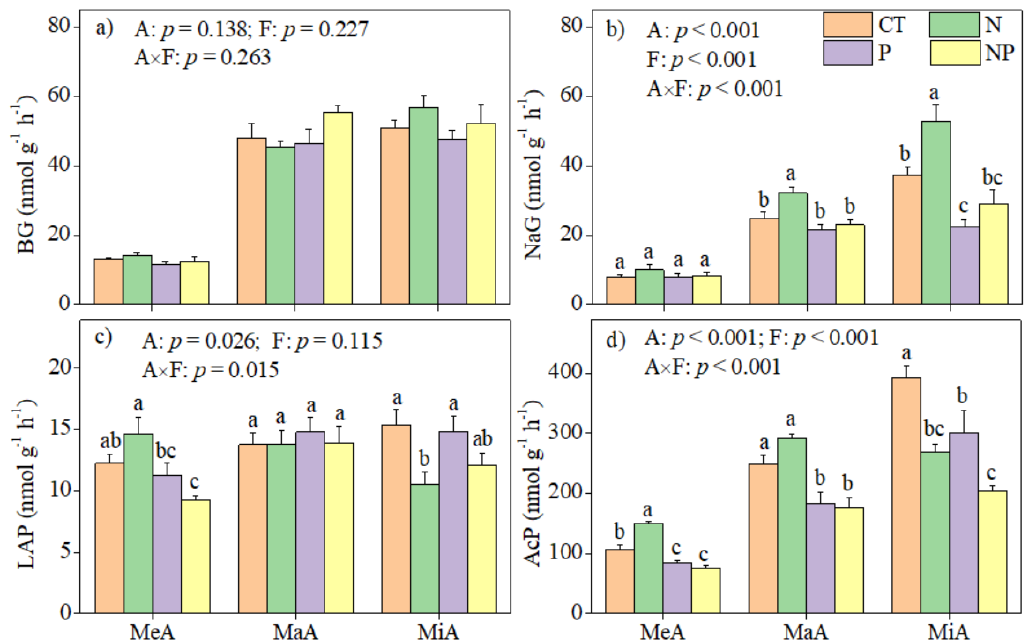
Figure 3. Effects of N and P fertilization on the activities of ( a ) β -1,4-glucosidase (BG), ( b ) β -N-acetyl- glucosaminidase (NaG), ( c ) leucine aminopeptidase (LAP), and ( d ) acid phosphatase (AcP) at 18 °C at the end of incubation. F and A represent fertilization and soil aggregate size, respectively. Differ- ent letters on the bars denote significant differences among fertilization treatments. MeA, MaA, and MiA represent mega-aggregates (>2.0 mm), macroaggregates (0.25 – 2.0 mm), and microaggregates (<0.25 mm). Data were represented as the mean with standard error.